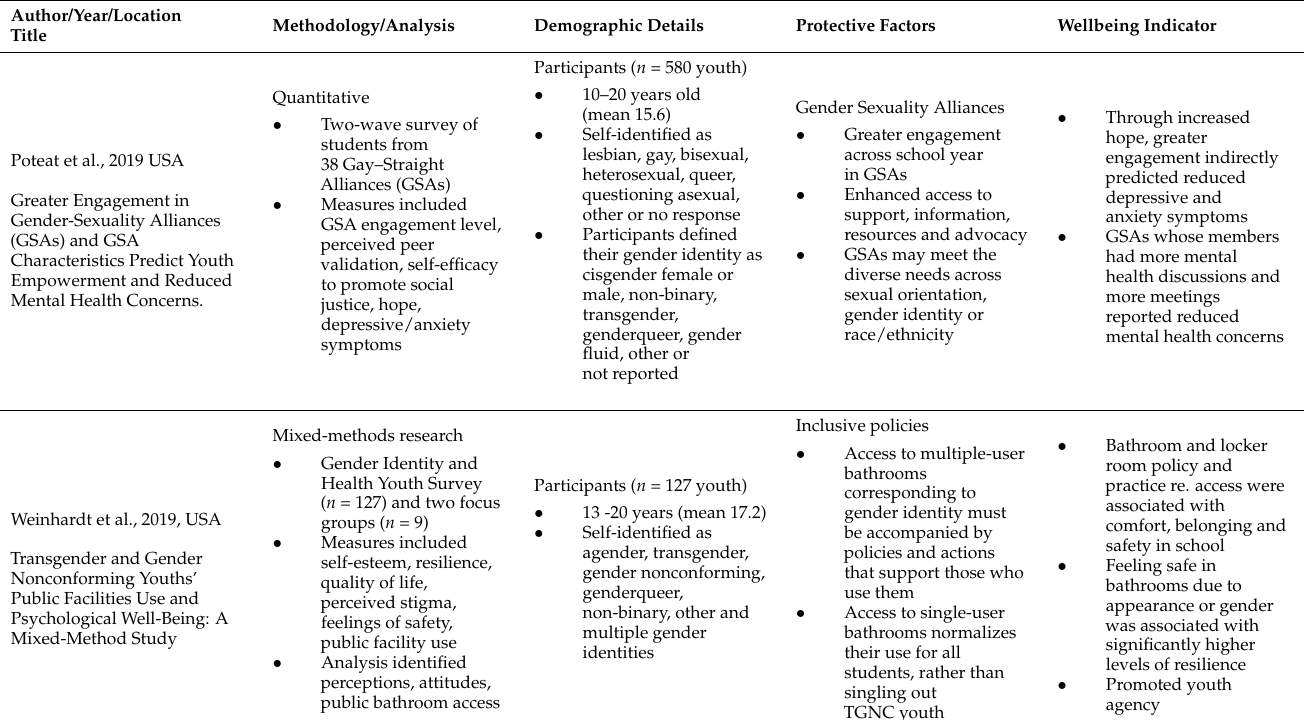
Table 6. Records of legal protective factors for LGBTI+ youth wellbeing: inclusive policies, curriculum, access and provision ( n =